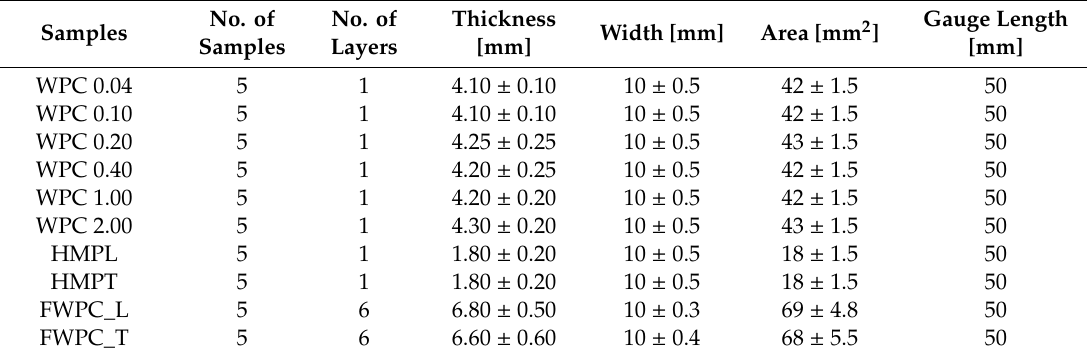
Table 1. The physical characteristics of samples for the tensile test.